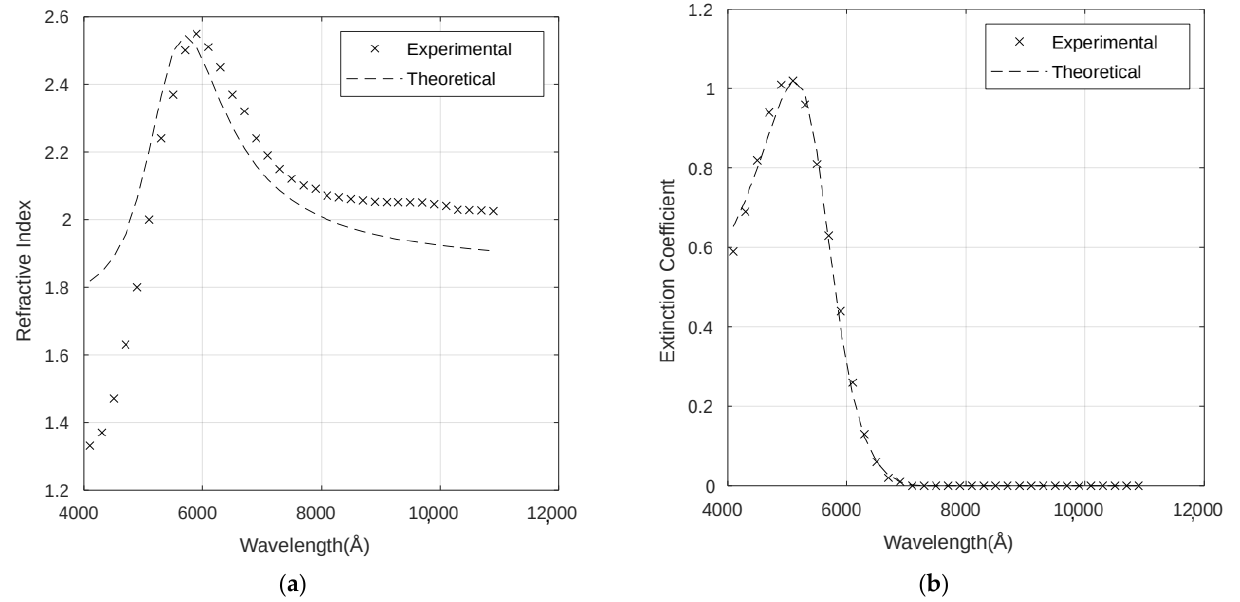
9 of 15 Table 3. Optimal values of the fitting parameters to the Forouhi Bloomer model for six different P3HT/G composites. The root mean square errors (RMSE) of the fits are also shown. G Loading (wt%)